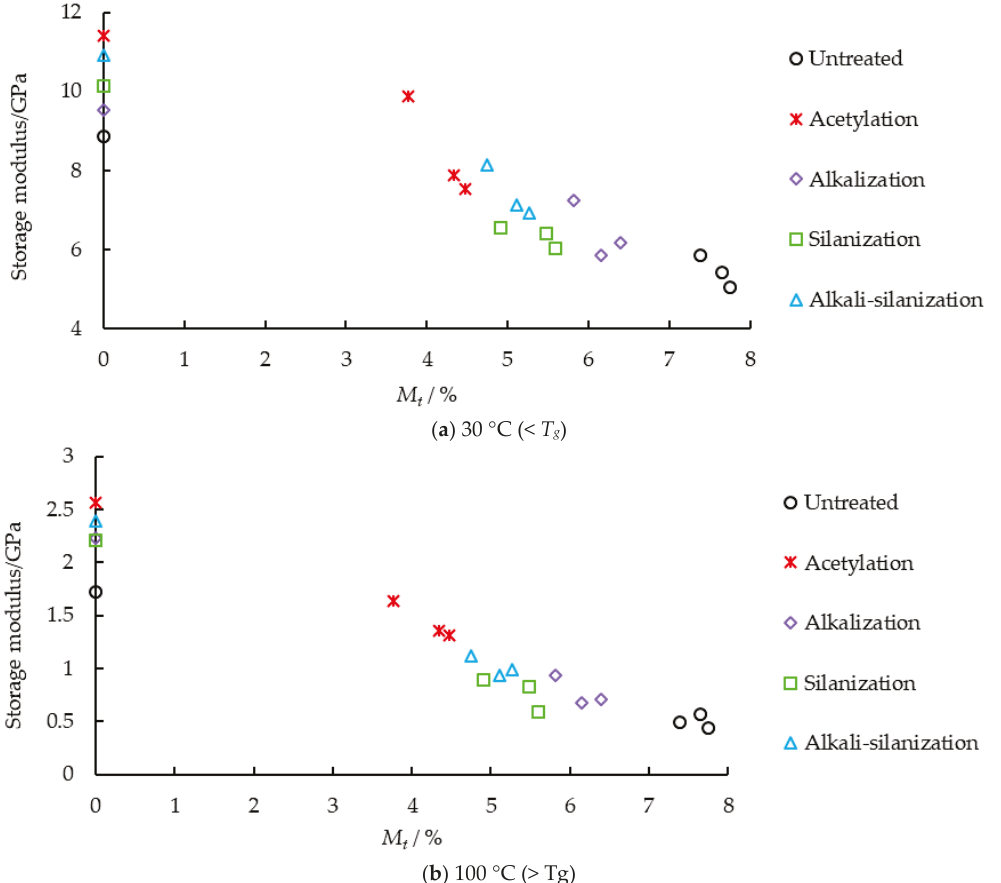
Figure 4. Relationship between storage modulus and moisture content.